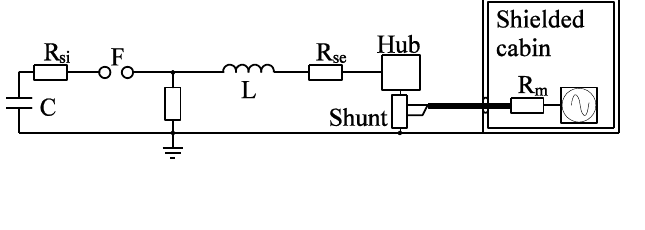
Figure 4. Laboratory setup for field measurements inside the wind turbine hub. A 1.2/50 µs impulse current with 1.3 kA amplitude was injected into the hub by an impulse